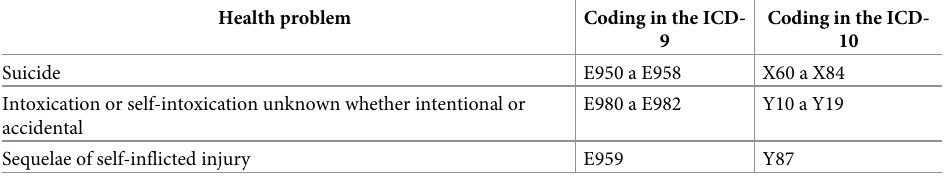
Table 1. Death records from the Mortality Information System of the SUS Information Technology Department (SIM/DATASUS), according to ICD-9 and